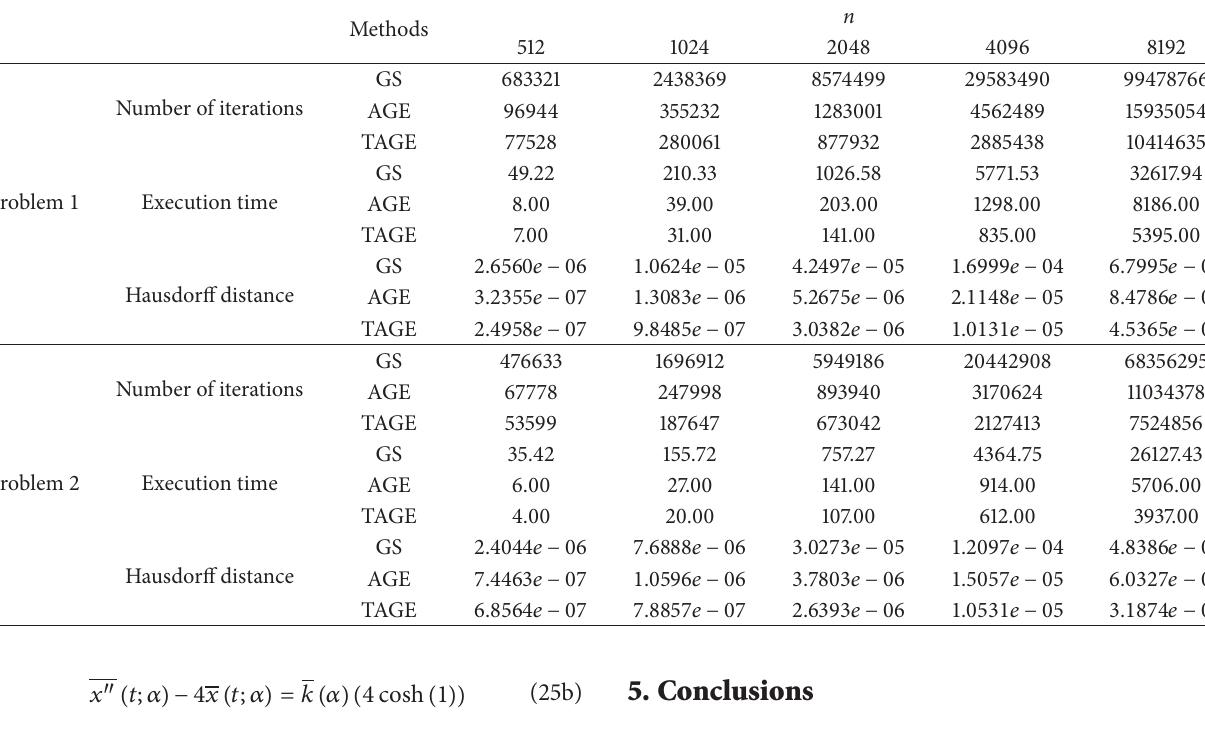
Table 4: Comparison of three parameters between GS, AGE, and TAGE methods at 𝛼 = 0 .